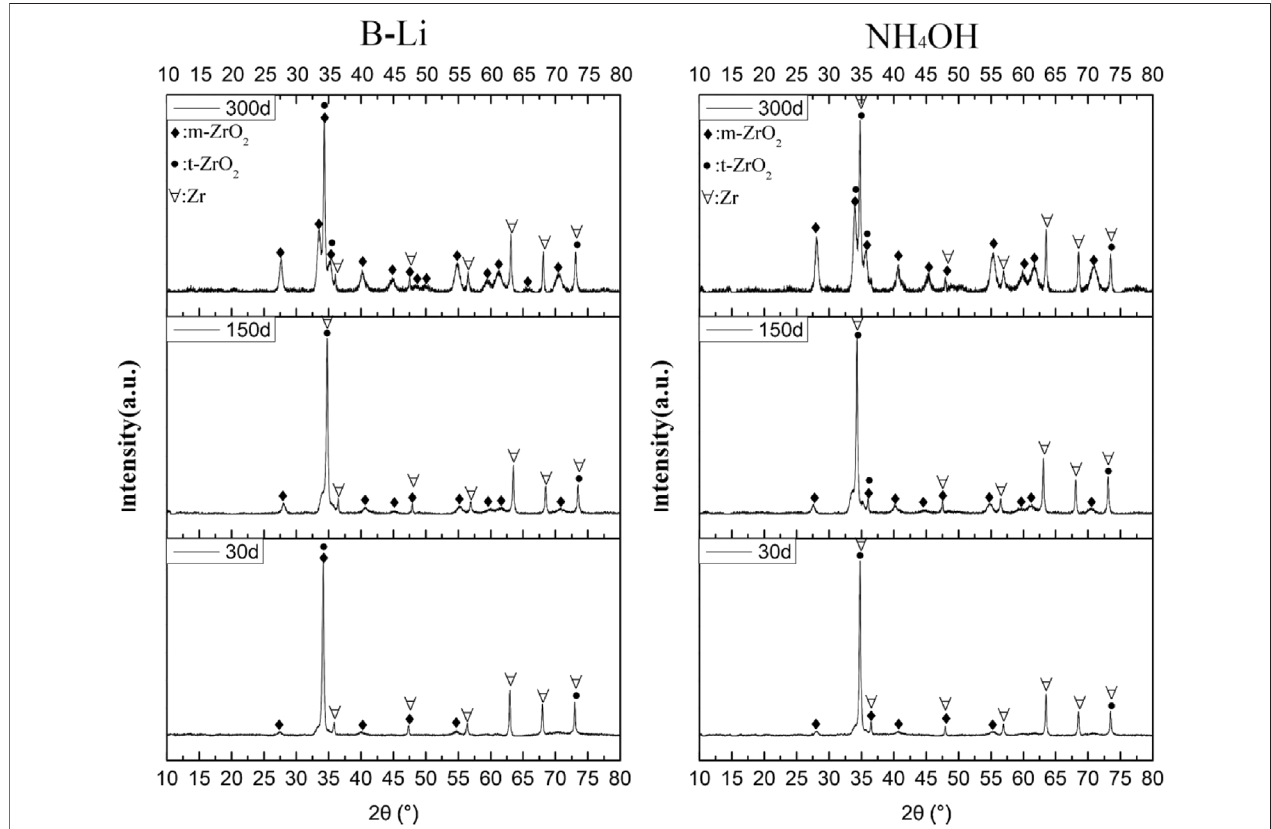
FIGURE 5 | XRD results of the specimens tested in two solutions after 30, 150, and 300 days.